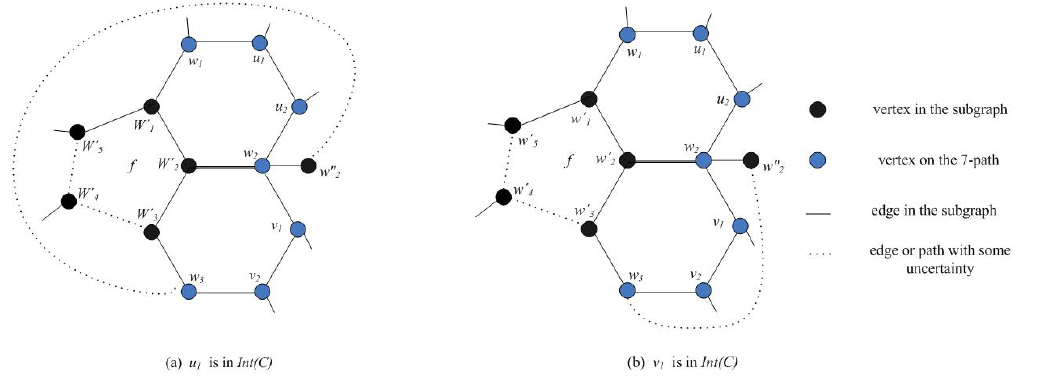
Figure 3. All the vertices on the 5 − -cycle f are 3-vertices. ( a ) u 1 in Int(C); ( b ) v 1 in